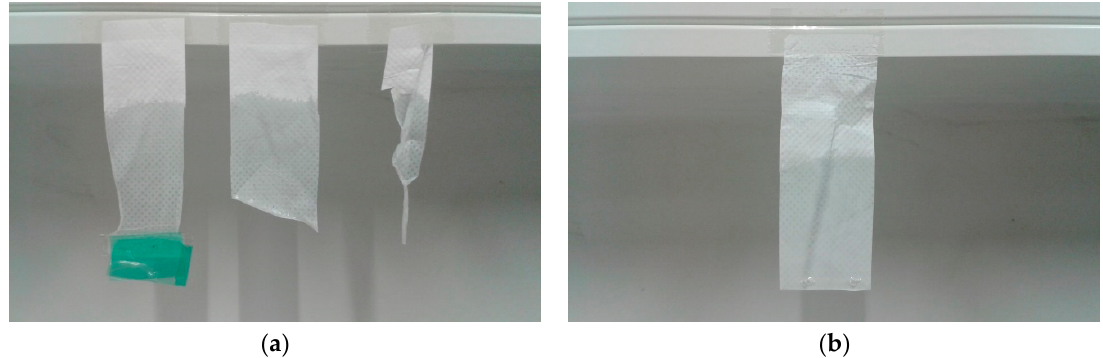
Figure 4. Electrospun PAN nanofiber mats ( a ) after being exposed to water; ( b ) after being exposed to water with soap.